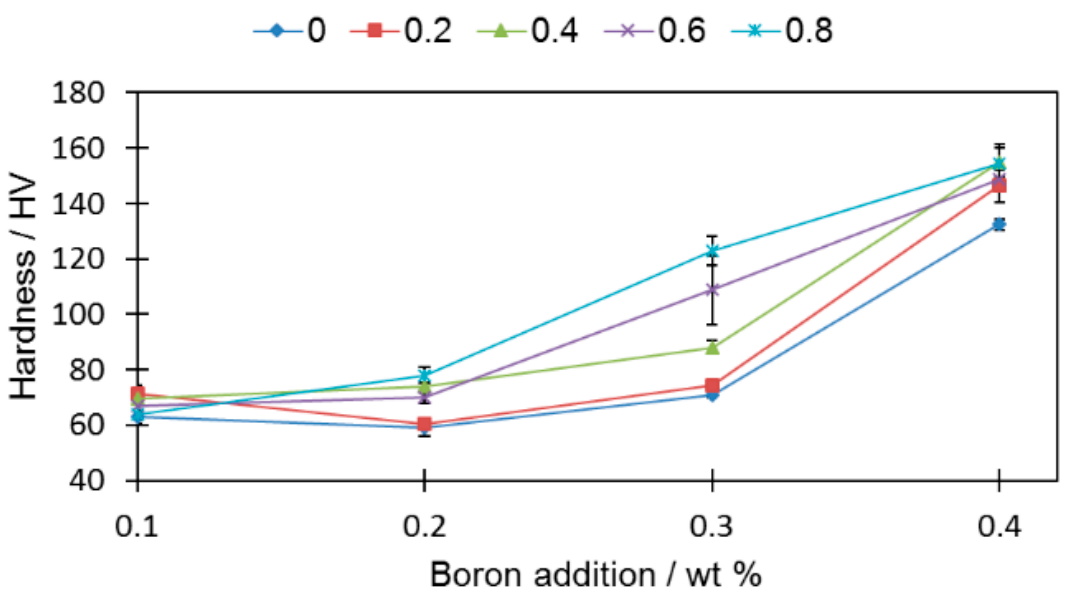
Figure 11. Hardness as a function of boron addition for different silicon nitride additions. Detailed data are available in Table S6 in the Supplementary Data.